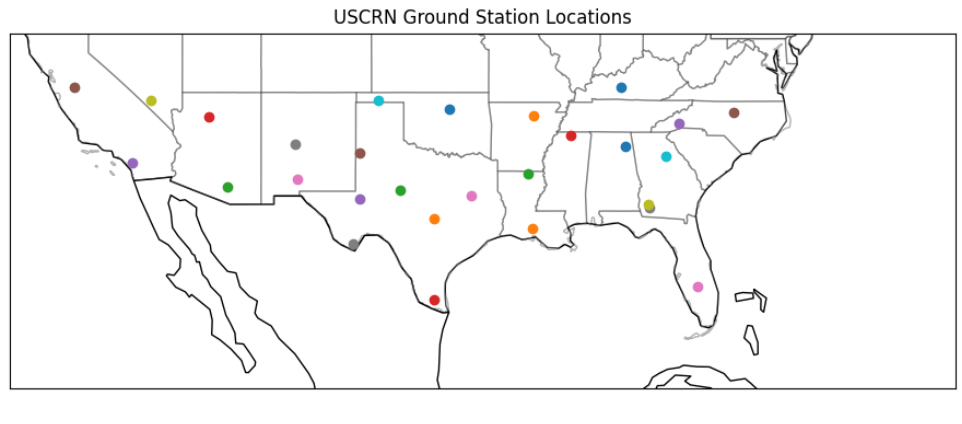
Figure 17. Locations of the 28 USCRN ground stations discussed. Stations were selected to provide geographic coverage from a consistent